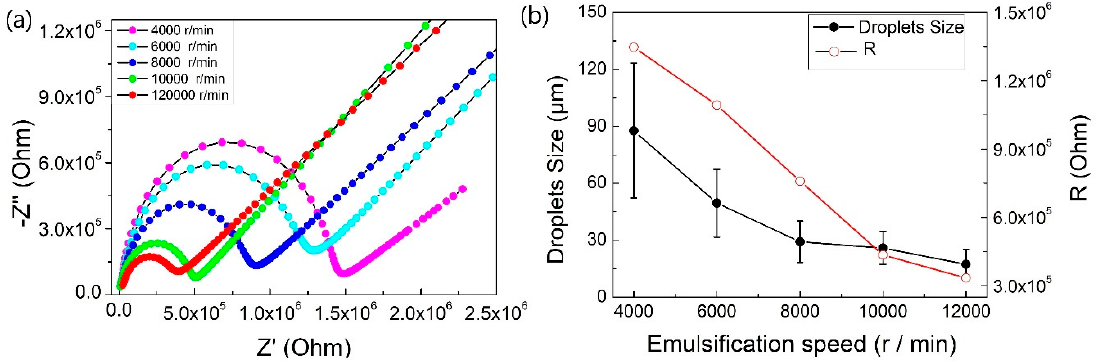
Figure 4. ( a ) Nyquist diagram of Pickering emulsions with different droplet size distributions and ( b ) emulsion droplet size change and corresponding fitting resistance value at different emulsification speeds.